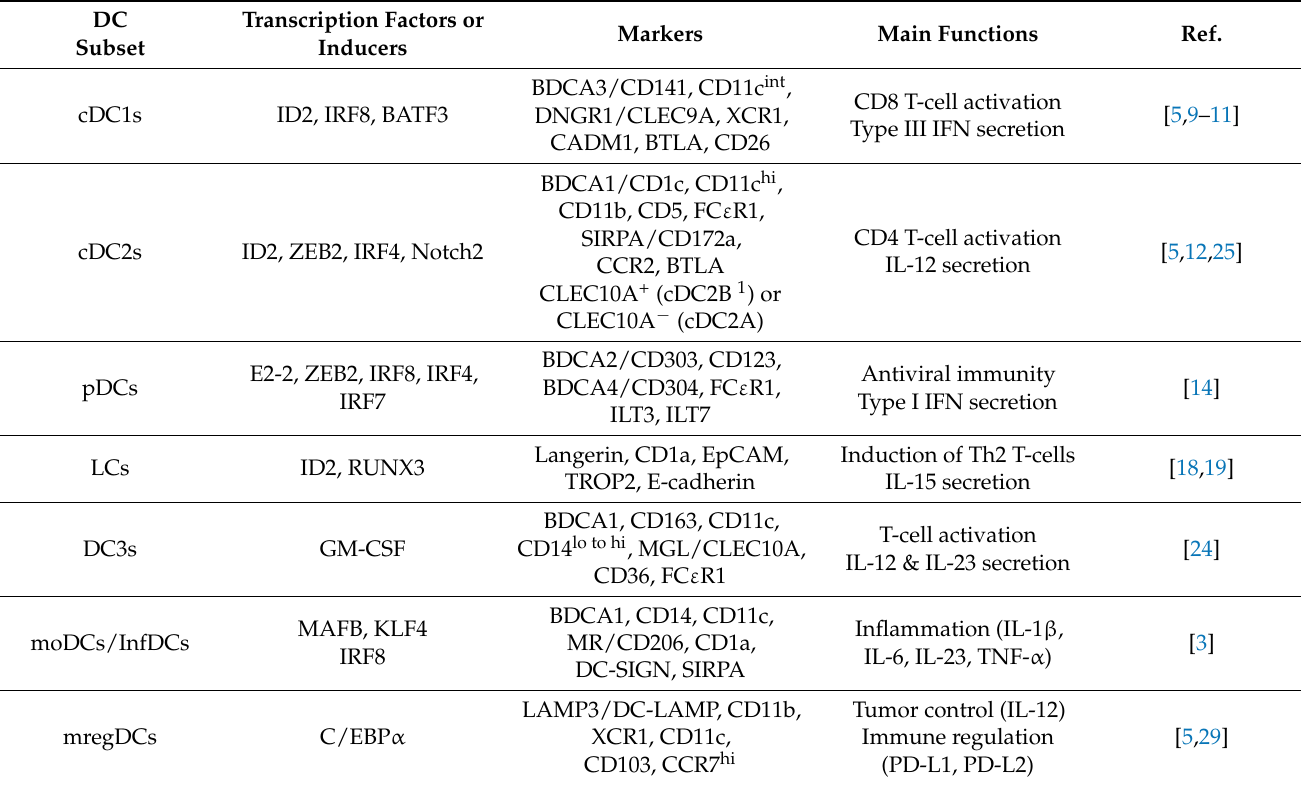
Table 1. Characteristics and functions of human DC subsets in the steady state or in an inflammatory setting [5,24,30,31].